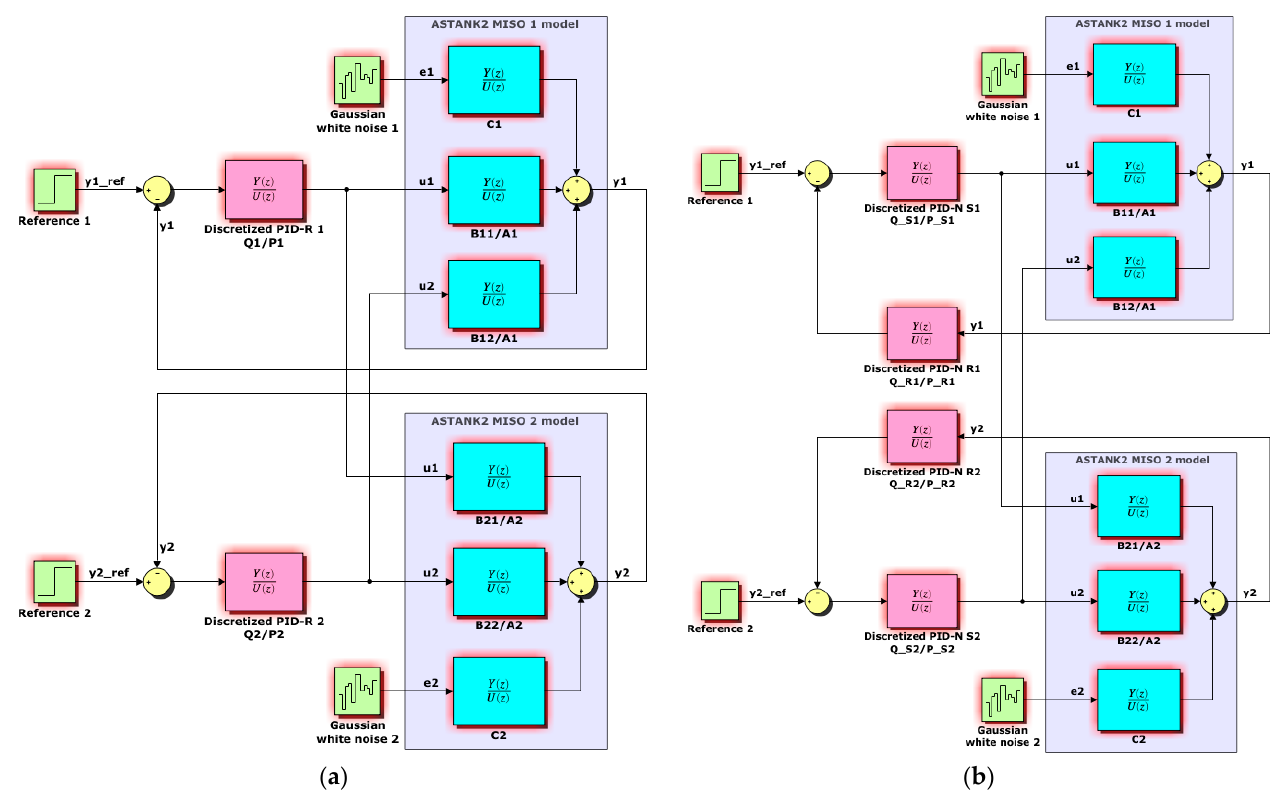
Figure 4. Closed loop PID structures for ASTANK2 installation with ( a ) PID-R; and ( b ) with PID-N.